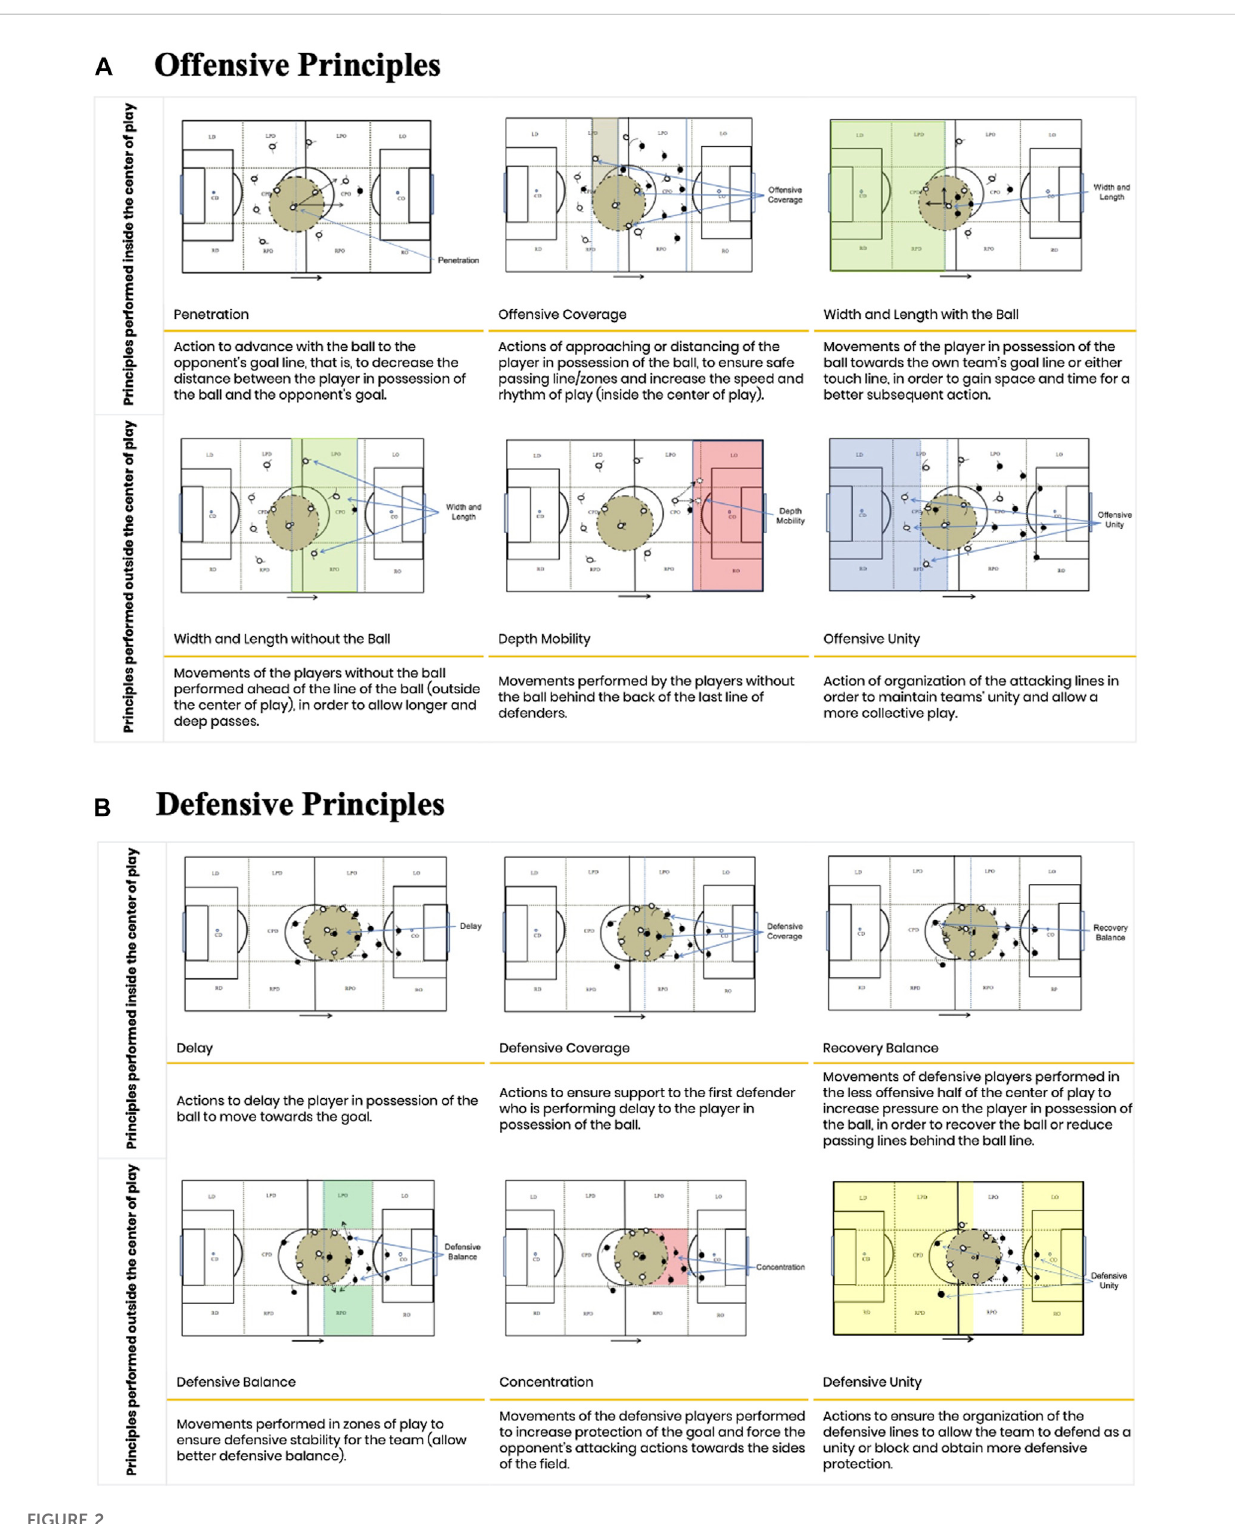
FIGURE 2 Description of the core tactical principles of soccer (A) offensive and (B)